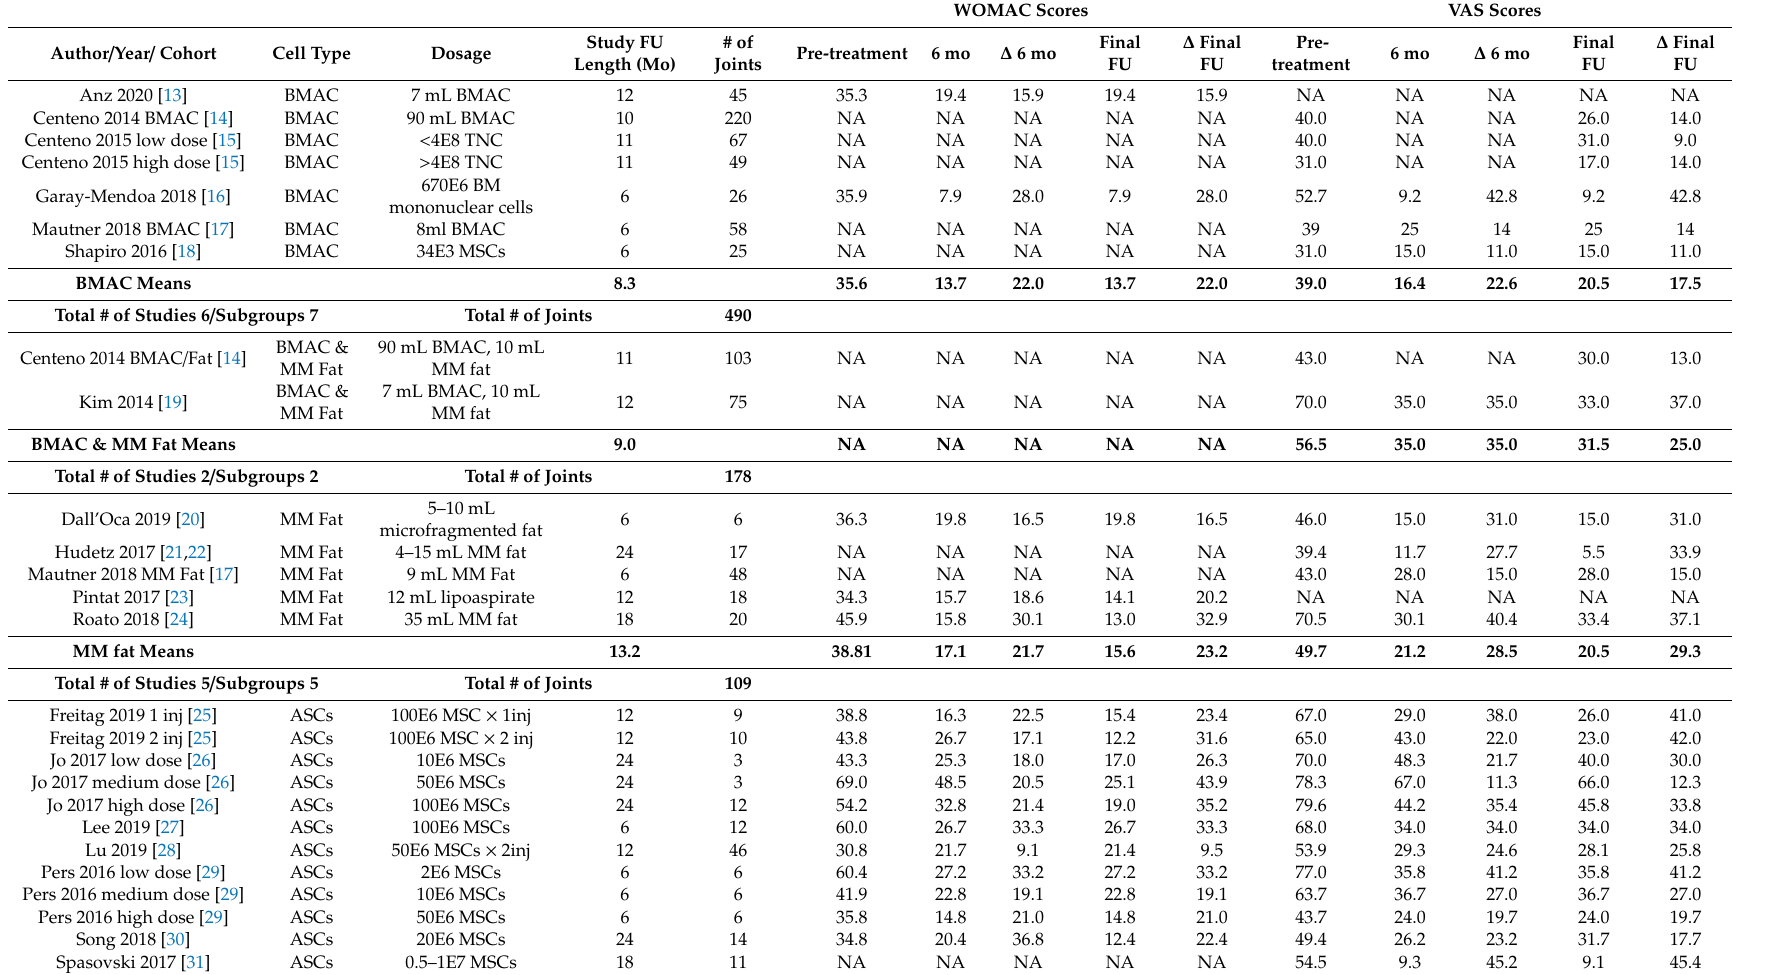
Table 1. Included MSC studies—includes all Group 1 and Group 2 studies, broken down by MSC